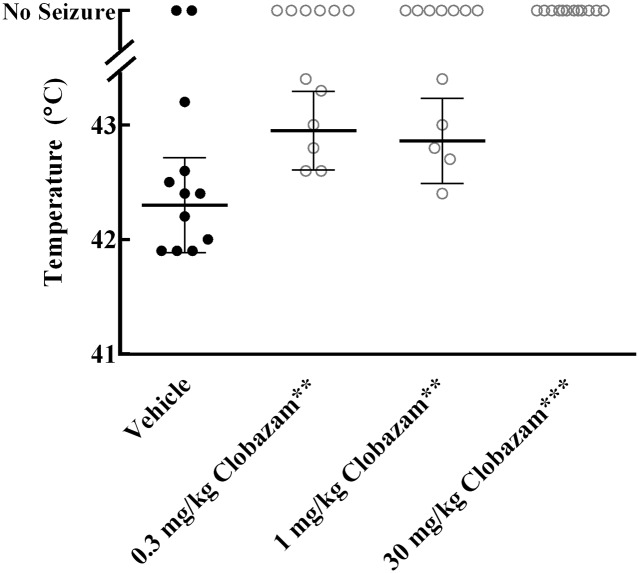
Pharmacological modulation of Gabra2 by clobazam.F1.Scn1a+/- mice underwent hyperthermia-induced seizure threshold testing after IP injections of vehicle or clobazam. The temperature at which generalized tonic-clonic seizure activity occurred is shown. Clobazam administration provided dose-dependent protection against hyperthermia-induced seizures. p values were determined by Mantel-Cox log-rank test (**p<0.01; ***p<0.001).